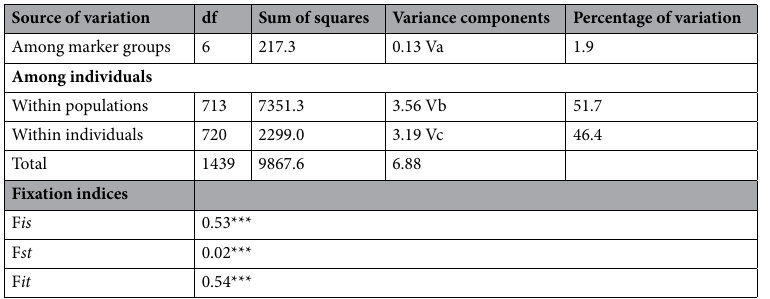
Table 2. Analyses of molecular variance (AMOVA) and fixation indices for the seven marker groups.